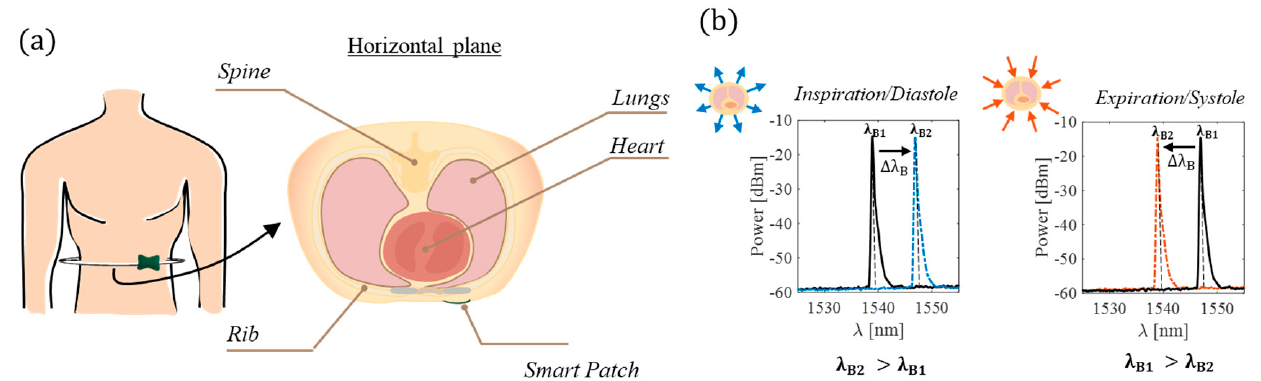
Figure 2. The smart patch working principle during breathing/heart beating: ( a ) the sensor placement and ( b ) the spectrum changes during inspiratory/diastolic (from black to blue line) and expiratory/systolic (from black to orange line) phases.